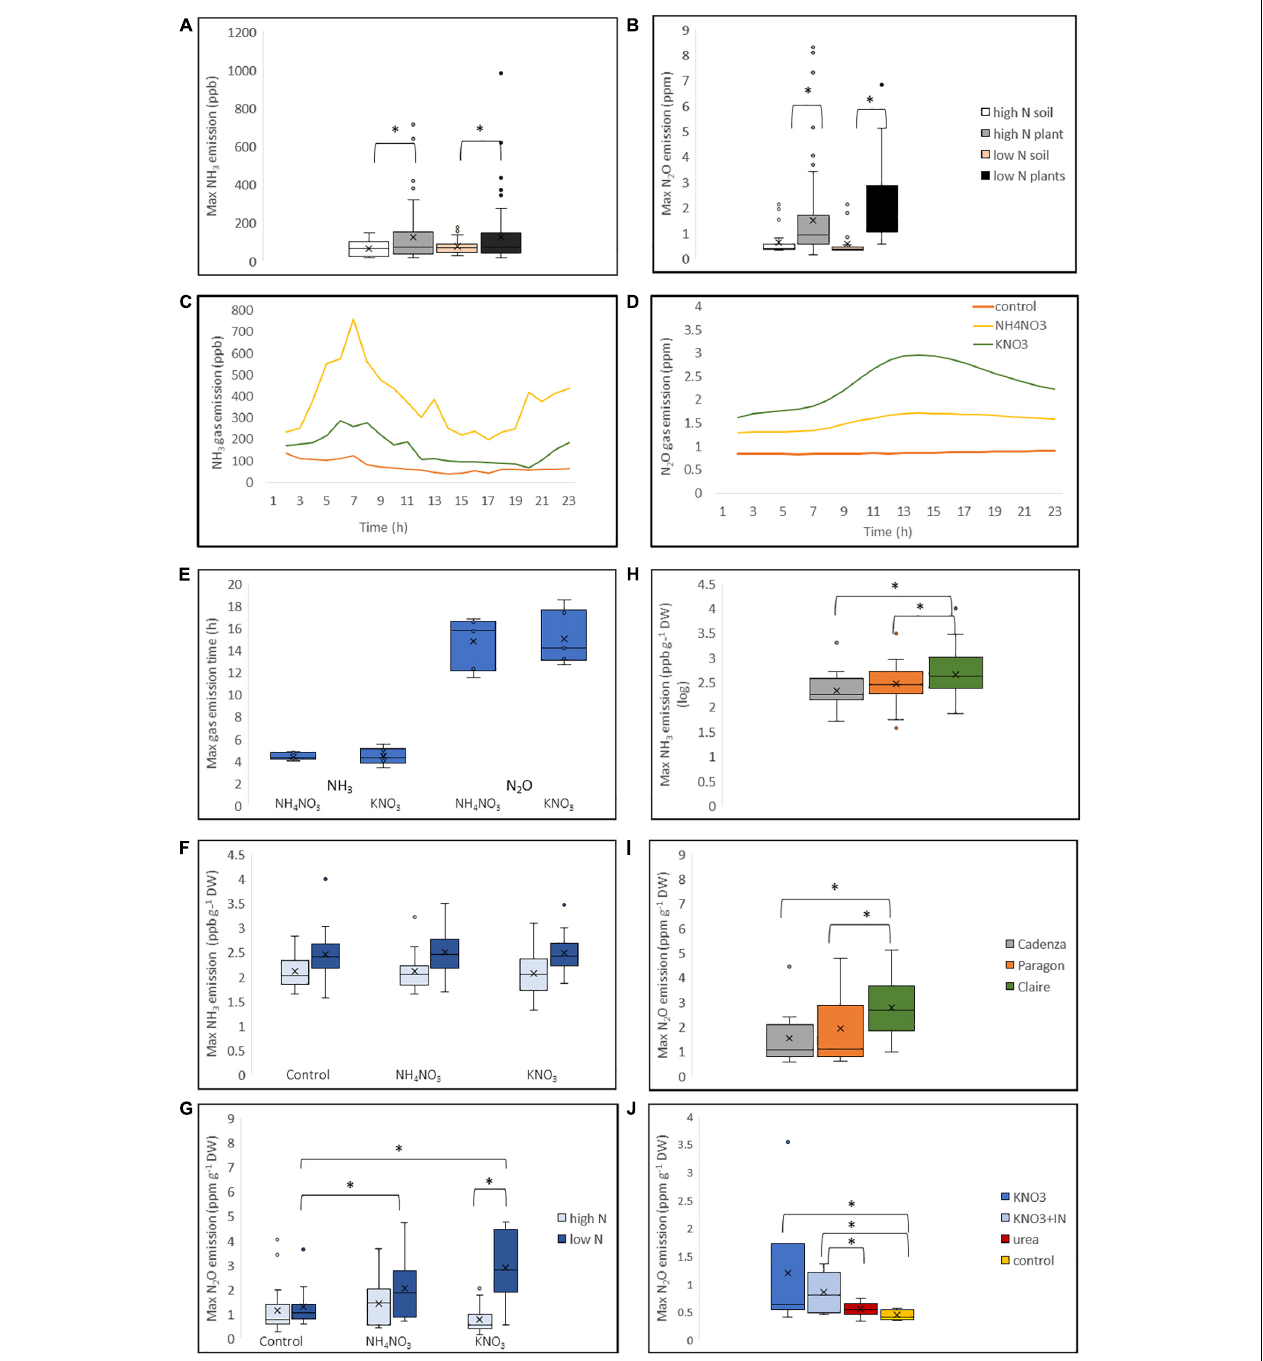
FIGURE 5 | Ammonia and N 2 O gas emission in response to N application in wheat. Three wheat varieties representative of the high-GS group (Cadenza, Paragon) and low GS-group (Claire) were grown under low and high N conditions, respectively, and treated with the equivalent of 250 kg N ha − 1 applied either as NH 4 NO 3 or KNO 3 immediately before gas measurements. Water was applied to control plants measured in parallel. For the soil control, above-ground plant tissue was cut off, but roots were retained (see text for details). Gas emission was measured using a gas analyser (Picarro G2508; United States) over a 24 h period. Maximum NH 3 (A) and N 2 O (B) emission from plants was significantly higher than the background emission from soil. Representative processed Picarro data for NH 3 (C) and N 2 O (D) emission are shown, with maximum NH 3 emission occurring earlier than maximum N 2 O emission (E) . The effect of the growth conditions and N treatment on maximum NH 3 and N 2 O emission was calculated using the combined data of the three genotypes showing higher emission from N-starved plants (F,G) . Genotypic differences between plants grown under low-N conditions are shown in (H,I) . Cadenza plants grown under low-N conditions were treated with urea and KNO 3 , with and with nitrate reductase inhibitor (NI), showing highest N 2 O emission in the KNO 3 treatment (J) . Data are derived from six replicates for each genotype and treatment. Asterisks indicate significant differences between means ( p < 0.05) of each treatment.